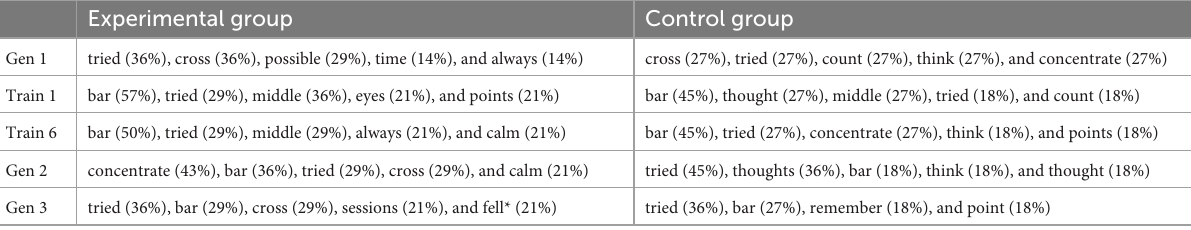
TABLE 4 Top five words, ranked by the percentage of users, separately for the experimental and control group. Experimental